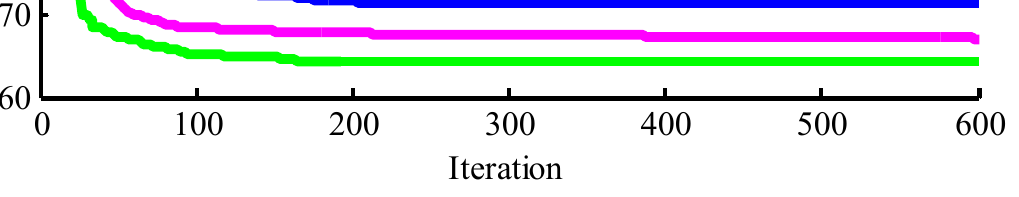
Figure 10. Convergence trends for Case 6.